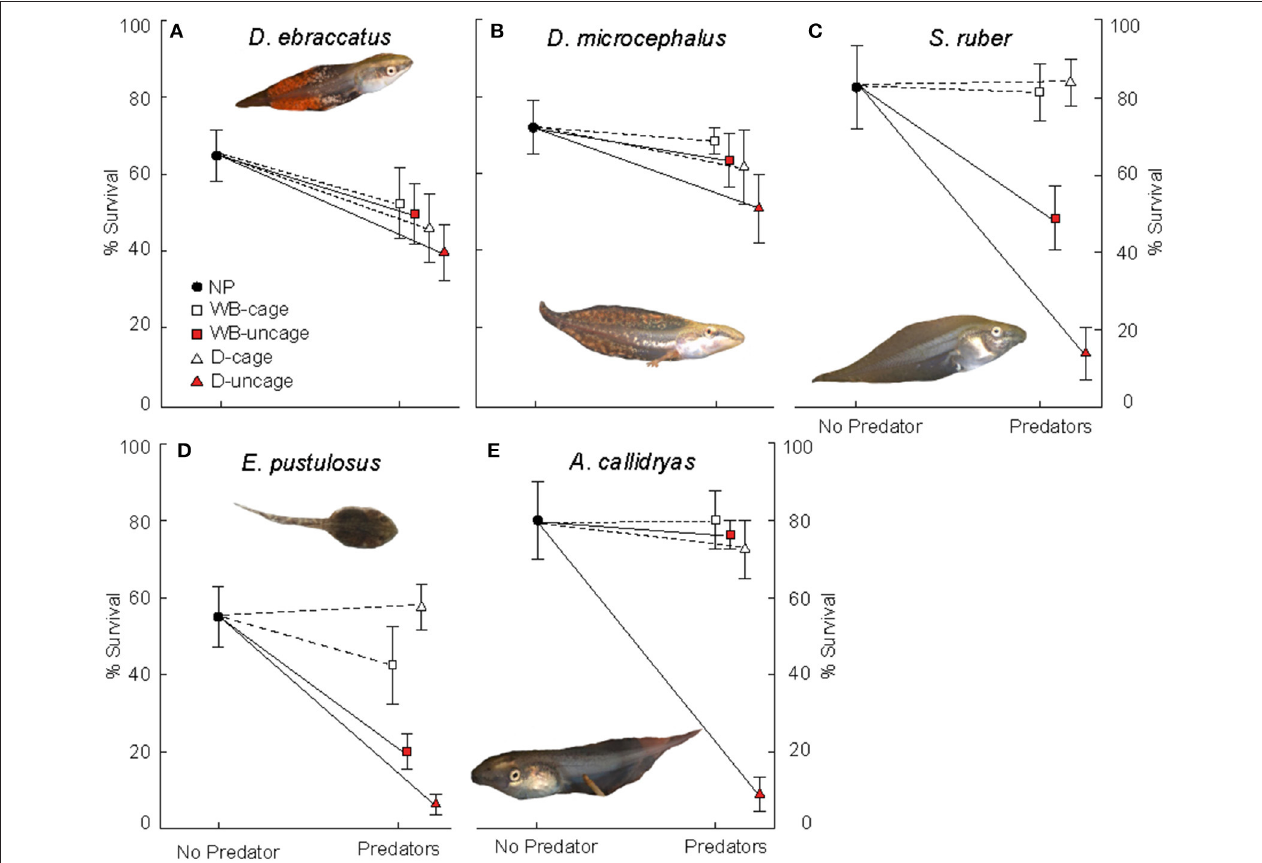
FIGURE 2 | Survival (mean ± SE, %) of: (A) D. ebraccatus ; (B) D. microcephalus ; (C) S. ruber; (D) E. pustulosus; and (E) A. callidryas in a non-predatory environment (left, No Predator) and in each of the 4 predatory treatments (right) of this experiment. Treatments with water bugs (WB) are represented with squares and dragonflies (D) are represented with triangles. Open white symbols and dashed lines represent caged predators and red filled symbols represent free predators. All tadpole photos by JT.